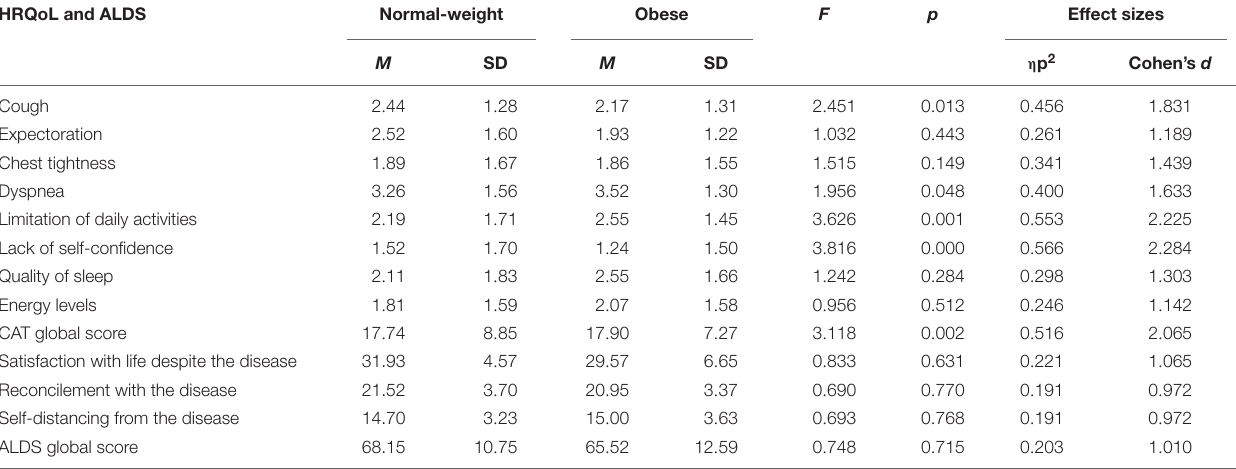
TABLE 3 | Differences between the groups divided according to